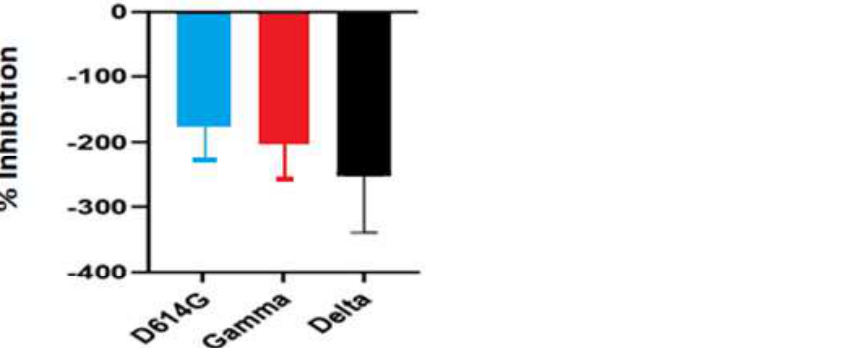
Pseudomonas aeruginosa